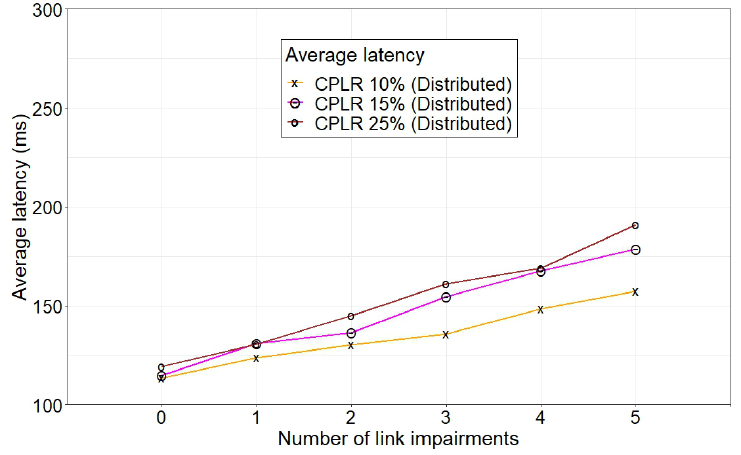
Figure 15. Average latency behavior of distributed network operation, during data plane link failures for various times under unreliable channel conditions in a 16-node grid